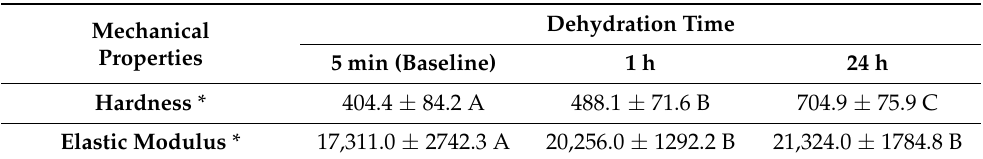
Table 1. Mean hardness and elastic modulus ± standard deviation of human dentin beams in MPa (n = 10